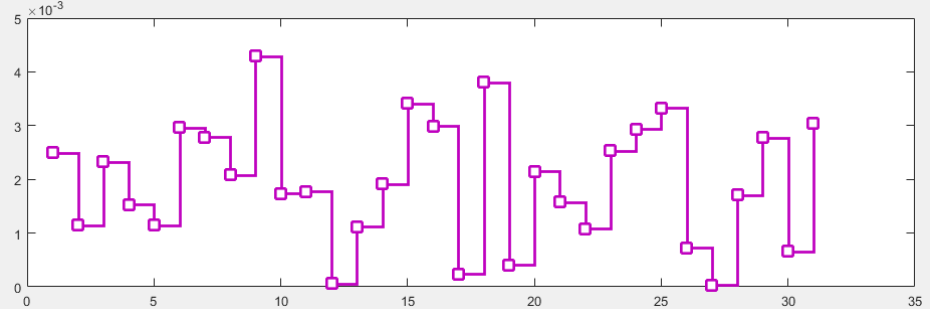
Figure 8. Figure of the relative error.